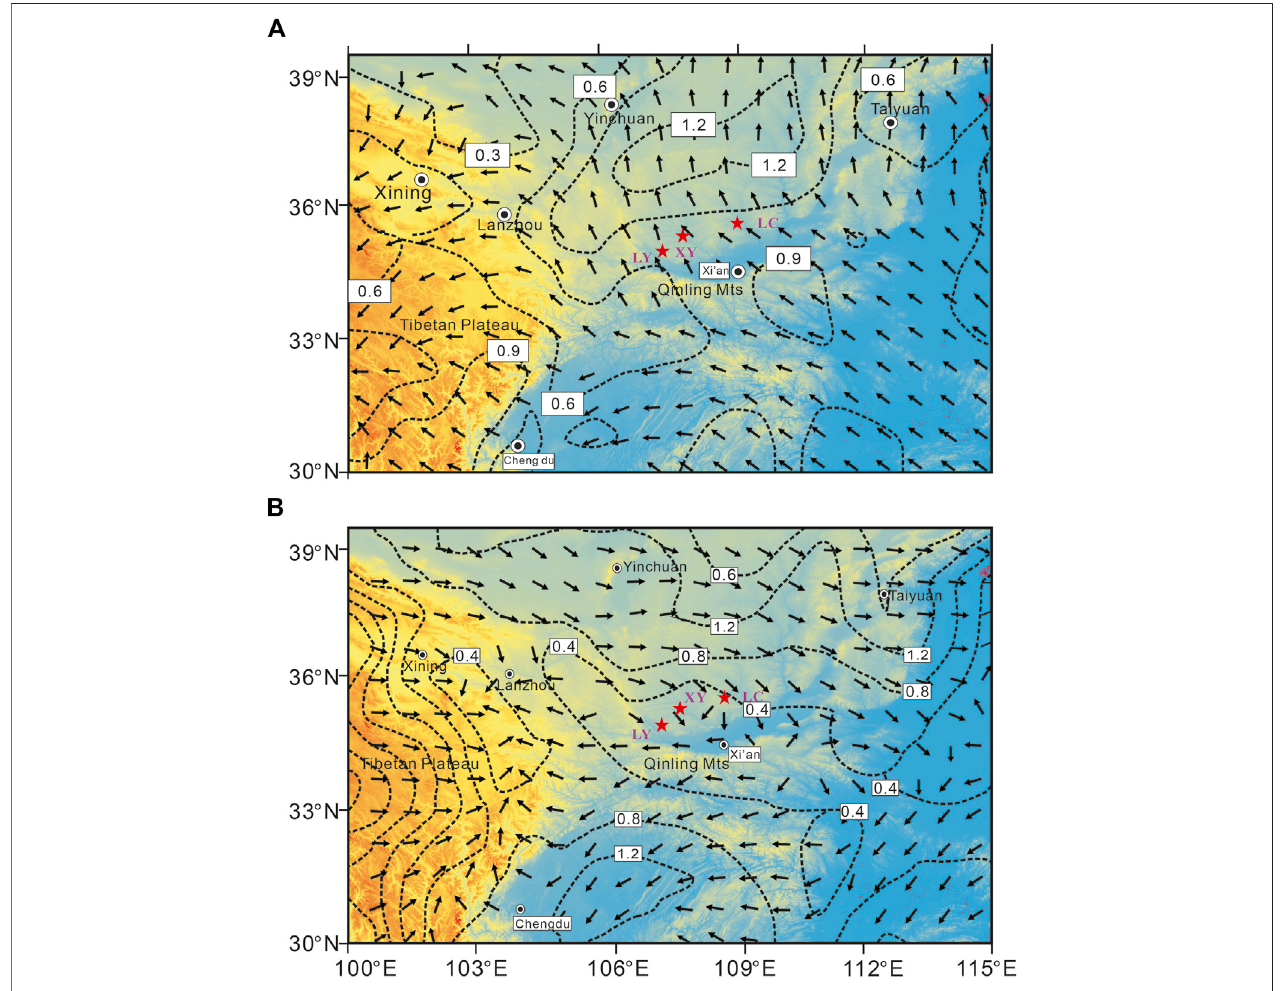
FIGURE 9 | The surface wind vectors for (A) the summer months, May – September and (B) the winter months, November – March, calculated from the 1950 to 2015 monthly long-term means. Data was compiled by NOAA-CIRES ’ s NCEP reanalysis atlas. On the CLP, summer prevailing winds come from the SE while winter prevailing winds comes from the NW, N, NE, E, and